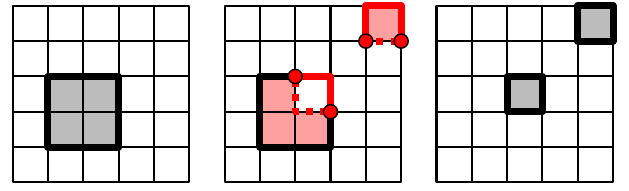
FIG. 2. A quantum error-correcting code based on the 2D Ising model. Qubits sit at faces and check operators at edges. Three stages of error correction are depicted. (Left panel) When the qubits in the shadowed area are flipped, the check operators on the boundary detect the change. (Middle panel) Noisy measure- ments of the syndrome are performed. Measurements fail at some edges (red) providing a pseudosyndrome that is not closed and thus has end points (red circles). The failed measurements are estimated to correspond to a minimal set of edges with the same end points (dotted red) so that the effectively recovered syndrome is the boundary of the shaded area. (Right panel) After error correction is performed, the new syndrome corresponds to the set of edges with an effectively wrong measurement